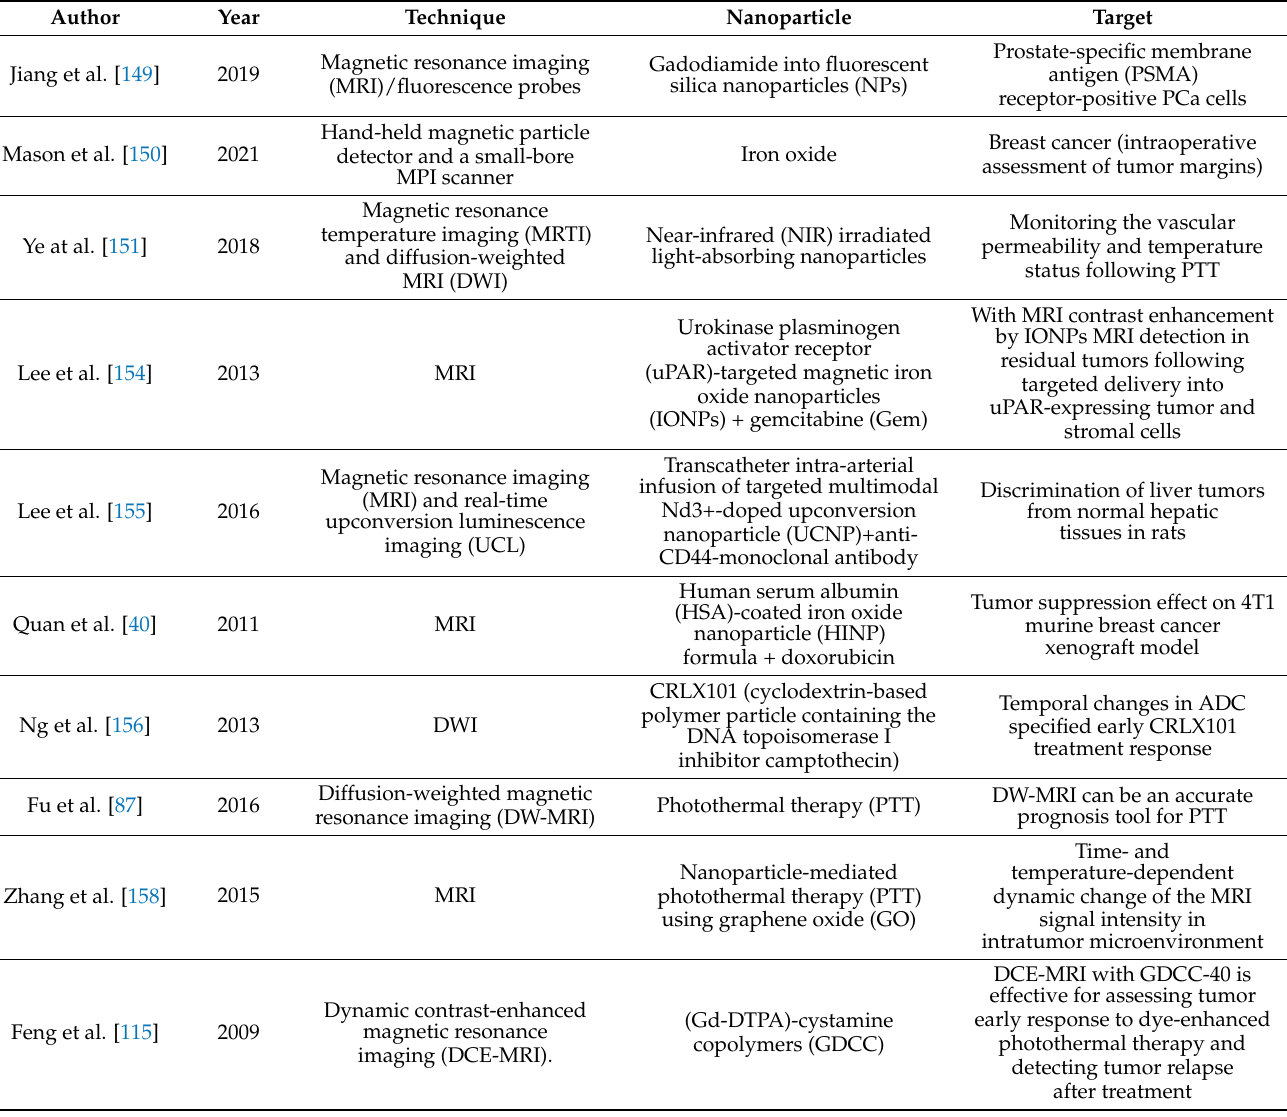
Table 1. Studies assessing MRI application in nanomedicine and